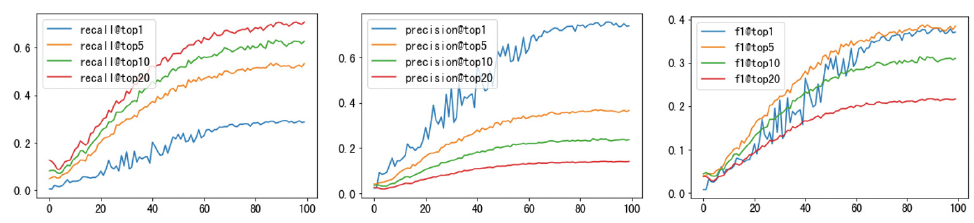
Figure 7. Recall@k, precision@k, and F1@k through 100 training epochs of the proposed M-CRBMs that take the Europeana dataset into